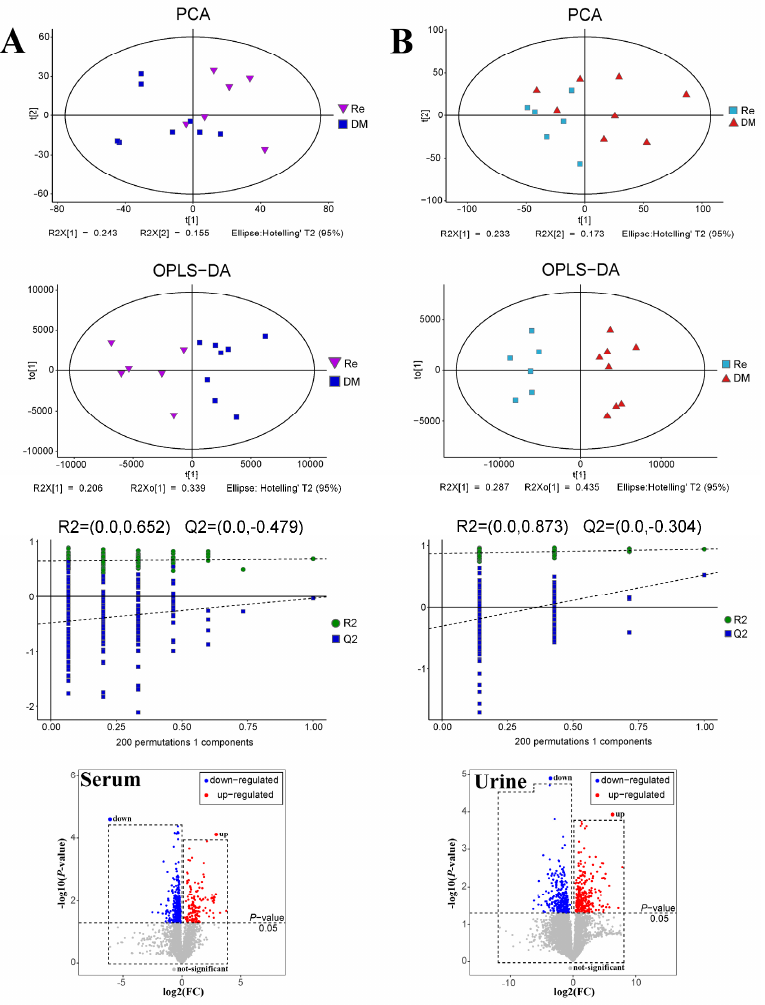
Figure 5. PCA analysis, OPLS-DA analysis, OPLS-DA permutation test and volcano plot of serum ( A ) and urine ( B ) samples from the ginsenoside Re compared to T2DM group, respectively. Univariate statistical analysis was then carried out to visualize the fold change (FC) value and significance test of difference ( p -value) through volcanic map analysis (Figure 5), red-dots represented significantly up-regulated metabolites, blue-dots represented signifi- cantly down-regulated metabolites, and gray-dots represented insignificantly metabolites ( p > 0.05). There were 10 (in serum) and 12 (in urine) differential metabolites filtered out in the Re compared to the T2DM group, which are represented in Table